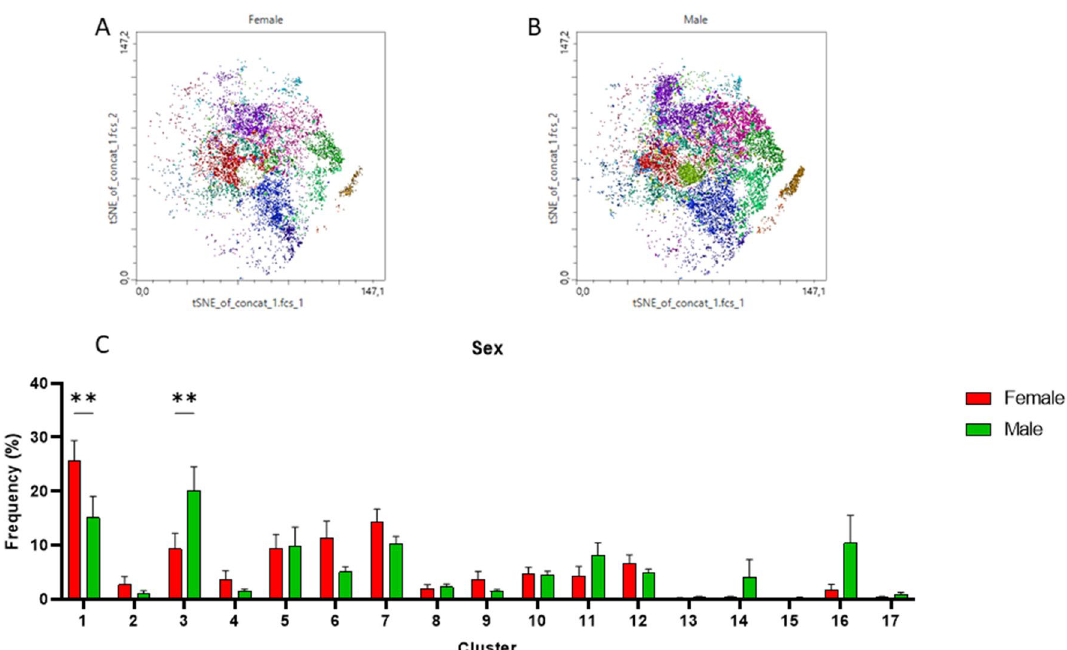
Figure 7. Comparison of Phenograph ‐ derived cluster pattern of neutrophils in ( A ) female and ( B ) male patients during COVID-19. Percentage distribution of clusters in female and male shown in a bar graph ( C ). Male patients had significantly more neutrophils plotted in cluster 3 ( p < 0.01) that includes highly activated neutrophils, whereas women had significantly more neutrophils plotted within cluster 1 that includes mature non-activated neutrophils (CD16 high CD62L high